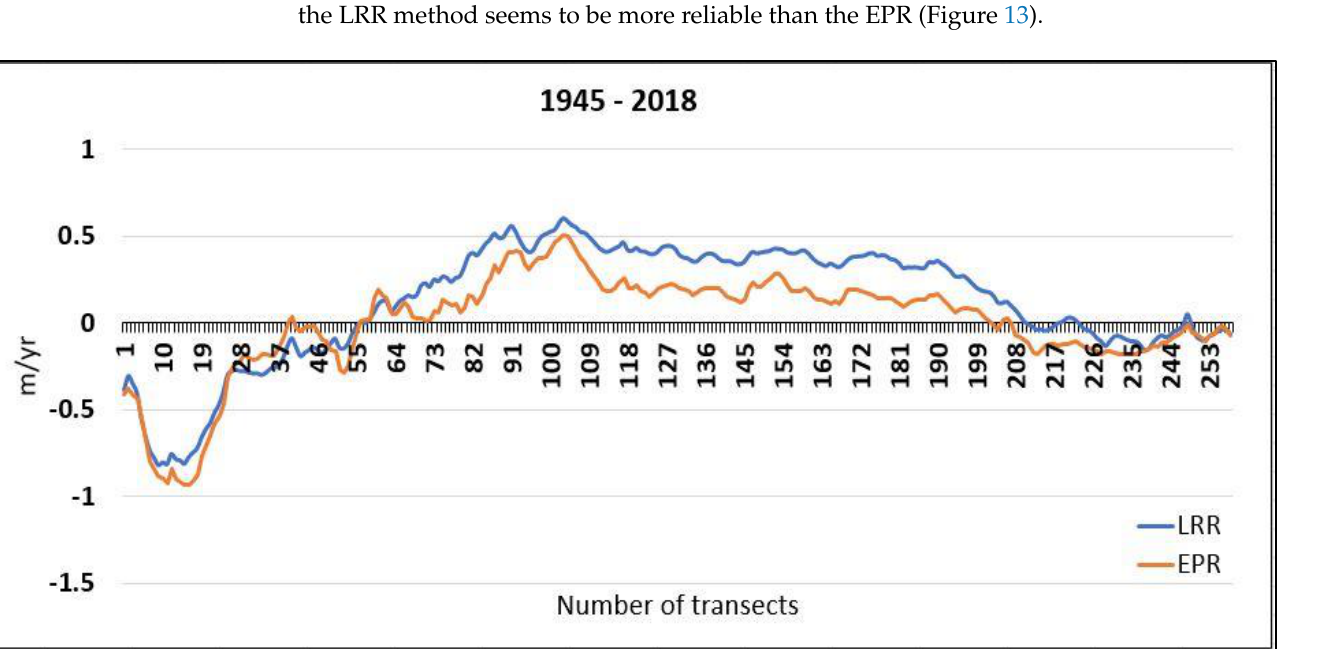
Figure 13. Erosion and accretion rates along the Prokopos Lagoon sea zone.